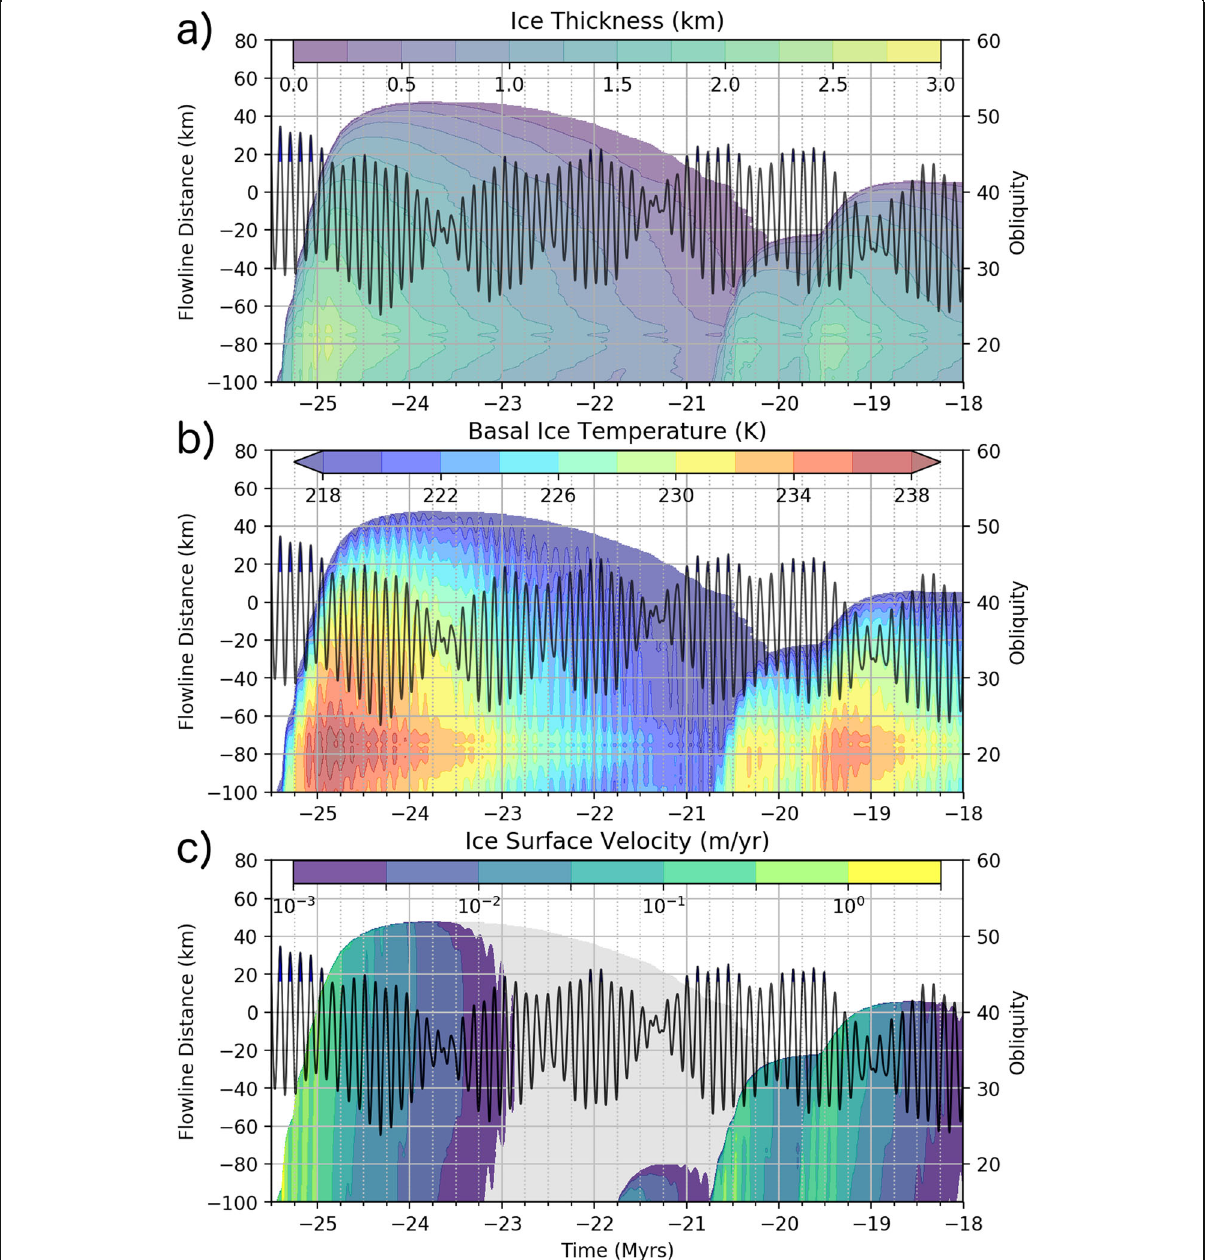
Fig. 10 Model results depicting changes in the ice extent and ice deposit properties in the distal portion of the simulated ice deposit. Ice thickness ( a ), basal ice temperature ( b ), and ice surface flow velocity ( c ) are indicated by the colored contours plotted against the distance along the flowline shown in Fig. 6 (left y -axis) and time ( x -axis). White regions in these panels contain no ice. The gray region in ( c ) indicates that ice is present, but the surface flow velocity less than 10 − 5 m/year. The black line in each panel gives the obliquity history over this time period according to the right y -axis with blue filled sections indicating times of ice accumulation in headward section of the simulated